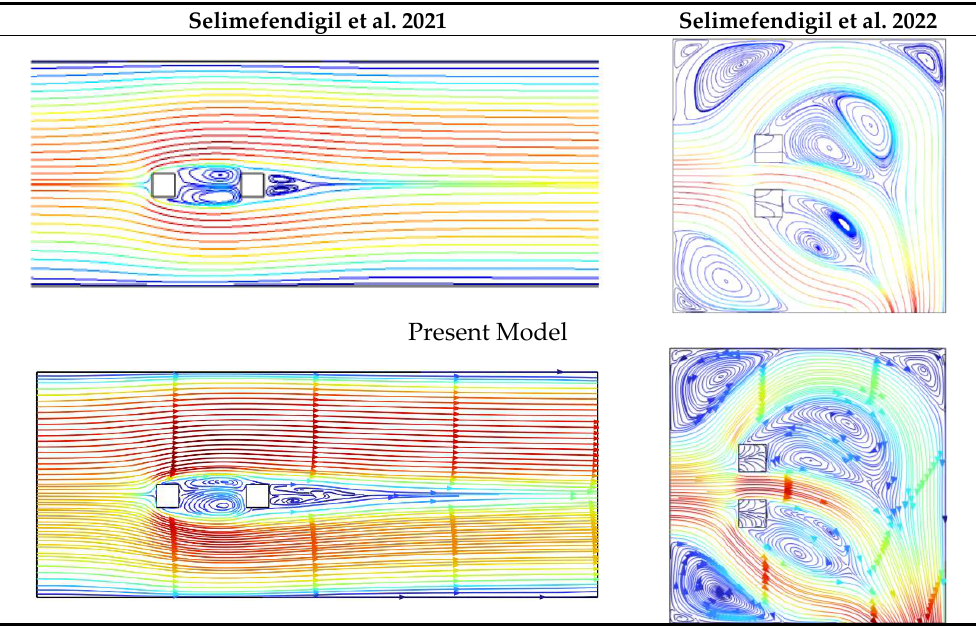
Table 3. Grid independency test, for Case 3, u in = 3 m/s, and T in = 45 °C.